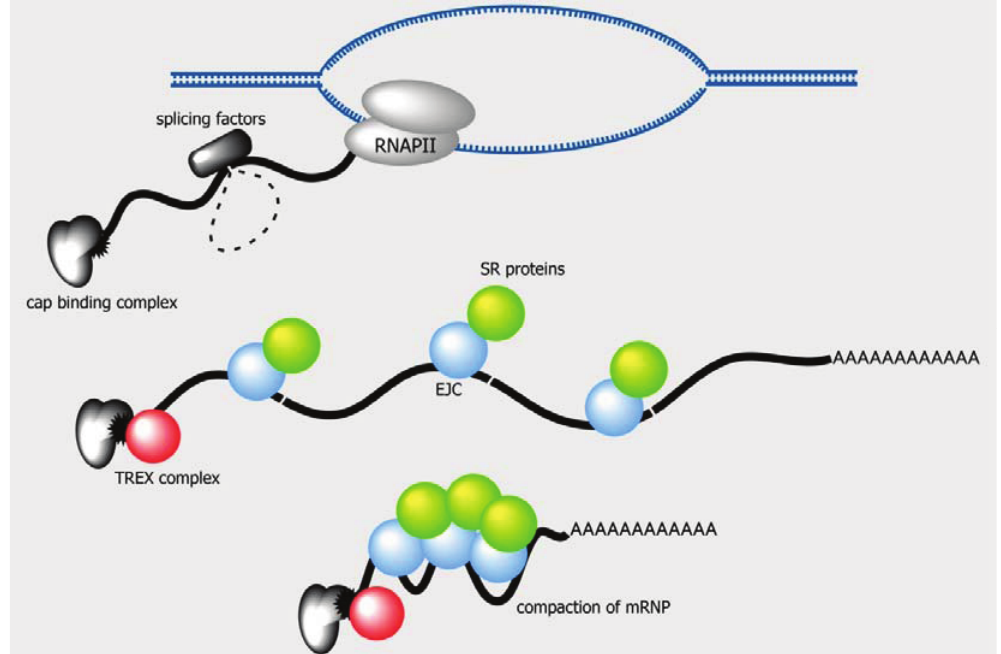
Figure 4. Splicing changes the structure and the composition of an mRNP. The exon-junction complex (EJC) and a subset of SR proteins are deposited on the mRNP upon splicing. Multimerization of the EJC along with the associated SR proteins promotes mRNP packaging and compaction. An earlier study has shown that splicing also recruits the TREX complex to the 5'-end of mRNA [130]. This compaction and the association of the nuclear export factors may promote the translocation of the mRNP through the